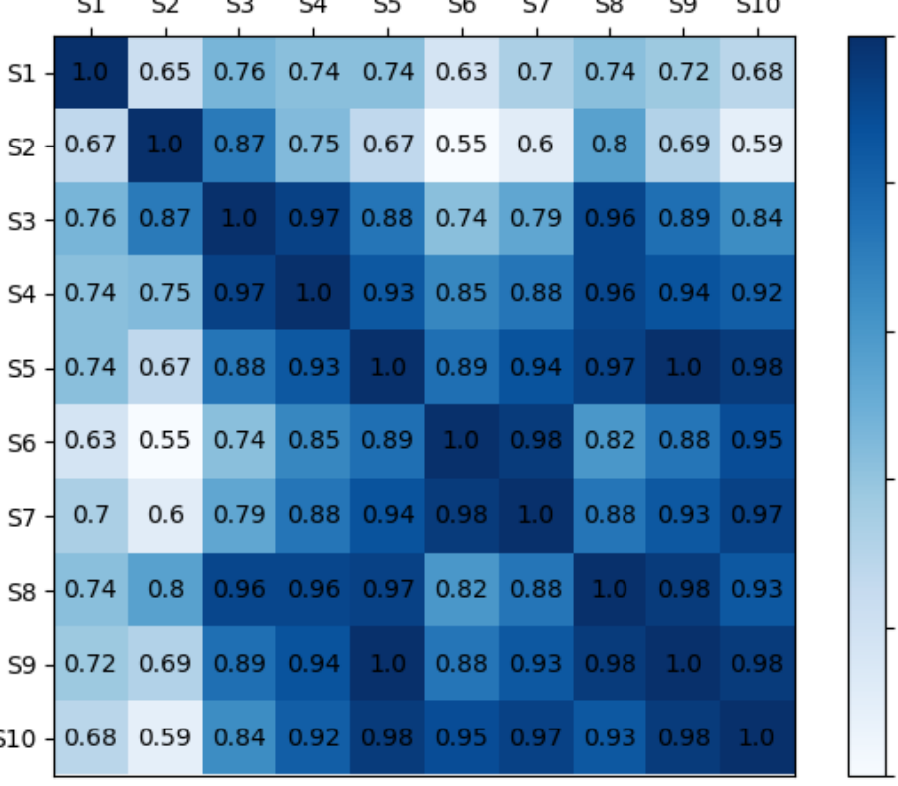
Figure 6. Correlation coefficients between sensors in the initial sensor array.